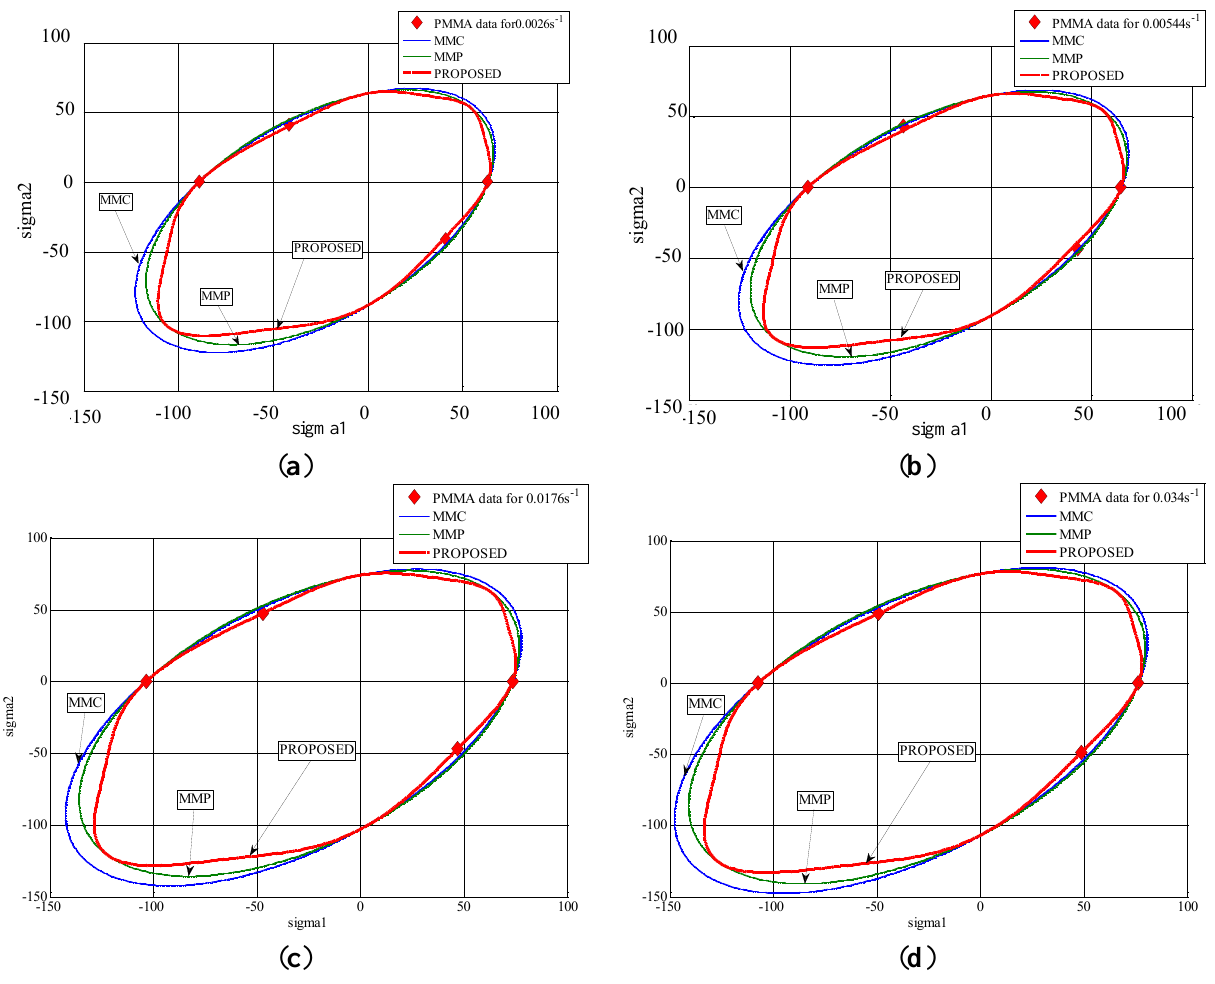
versus σ ): for equivalent strain I II